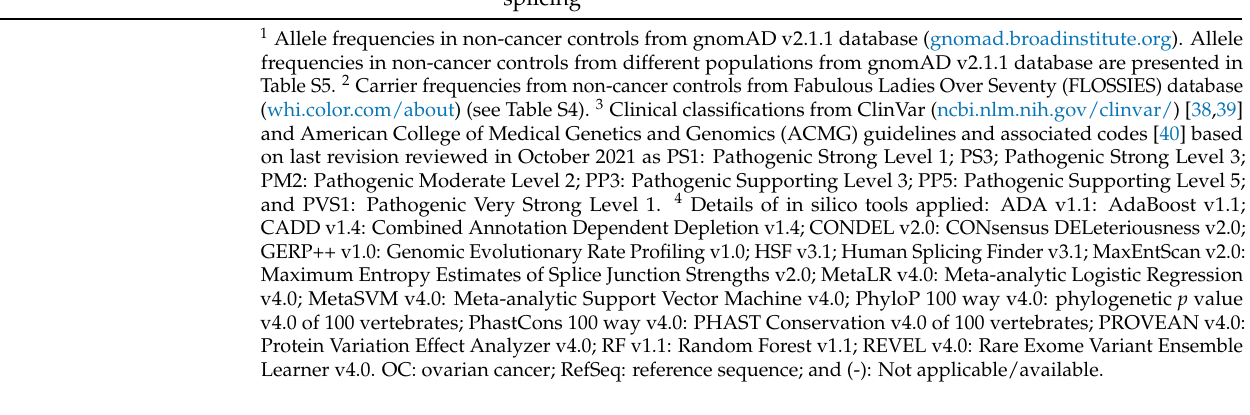
Table S5. 2 Carrier frequencies from non-cancer controls from Fabulous Ladies Over Seventy (FLOSSIES) database (whi.color.com/about) (see Table S4). 3 Clinical classifications from ClinVar (ncbi.nlm.nih.gov/clinvar/) [38,39] and American College of Medical Genetics and Genomics (ACMG) guidelines and associated codes [40] based on last revision reviewed in October 2021 as PS1: Pathogenic Strong Level 1; PS3; Pathogenic Strong Level 3; PM2: Pathogenic Moderate Level 2; PP3: Pathogenic Supporting Level 3; PP5: Pathogenic Supporting Level 5; and PVS1: Pathogenic Very Strong Level 1. 4 Details of in silico tools applied: ADA v1.1: AdaBoost